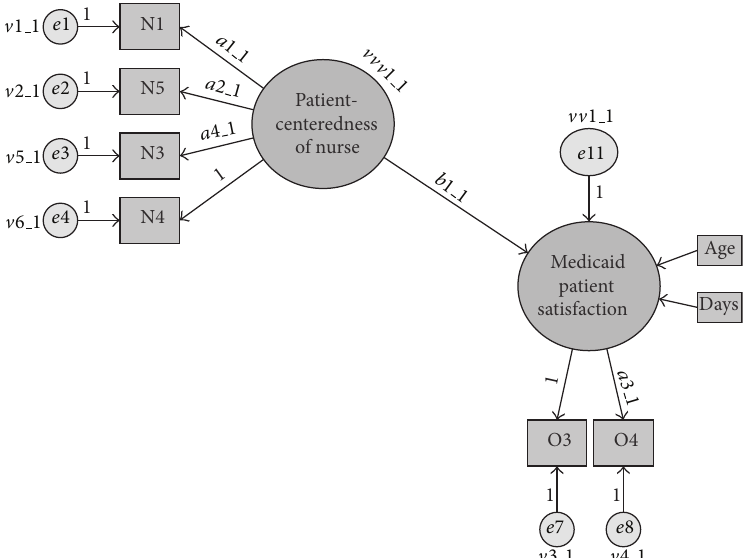
Figure 3: Hypothesized structural model. Key: e1–e4, e7-e8: error variances for each of the observed variables. a1 1, a2 1, a4 1, a3 1: factor loadings (i.e., regression weights). b1 1: regression weight (i.e., coefficient for the association between patient-centeredness and satisfaction). e11: disturbance (i.e., unexplained variance) for the latent variable, patient